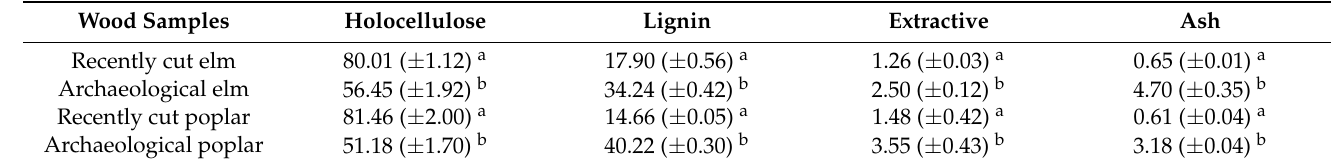
Table 1. Chemical compositions of recently cut and archaeological elm and poplar